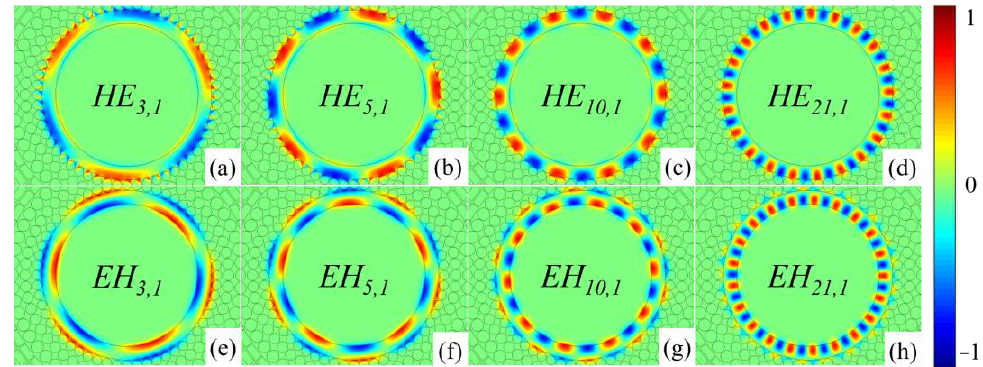
Figure 4. Electric field intensity distribution diagram: ( a ) HE 3,1 , ( b ) HE 5,1 , ( c ) HE 10,1 , ( d ) HE 21,1 , ( e ) EH 3,1 , ( f ) EH 5,1 , ( g ) EH 10,1 , ( h ) EH 21,1.